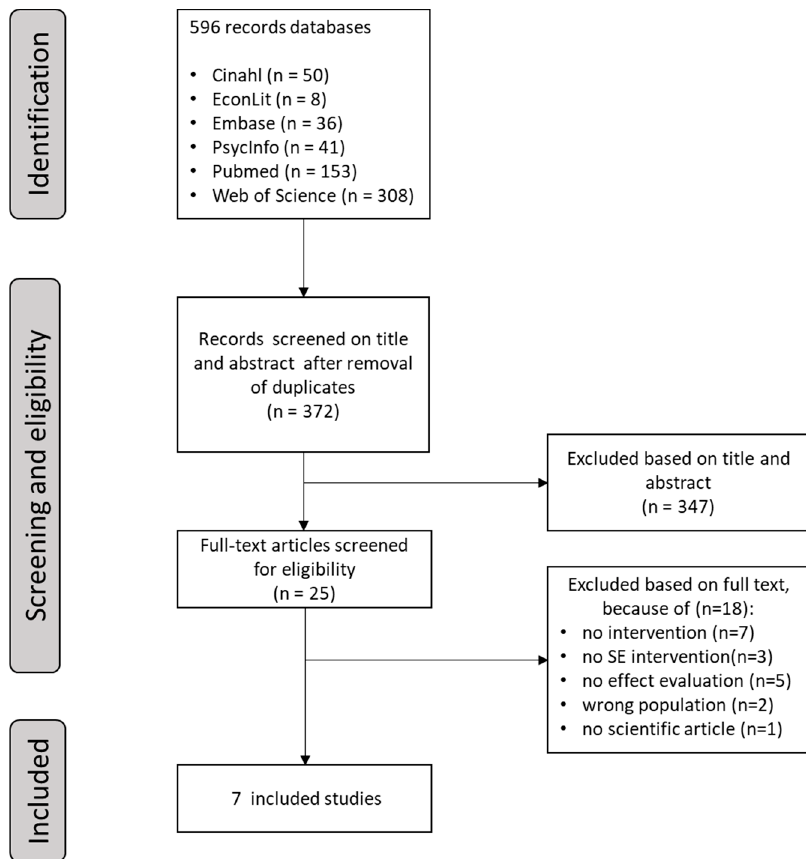
Figure 1. Selection of studies: Systematic Reviews and Meta-Analysis (PRISMA) flowchart.